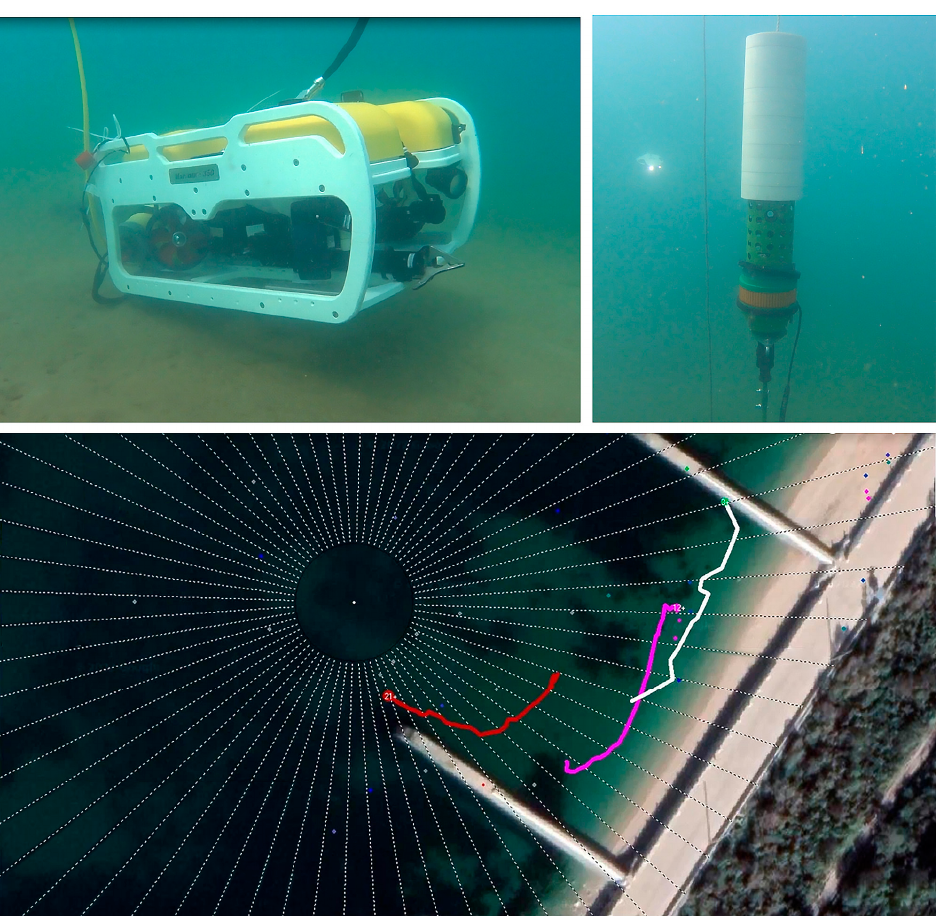
Figure 9. MIoT platform experimental